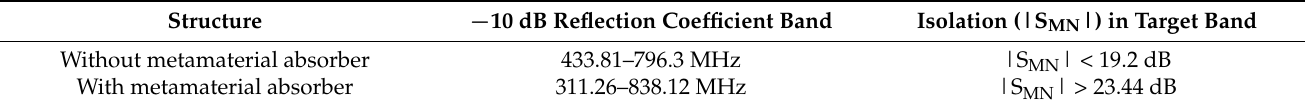
Figure 16. Proposed antenna: ( a ) geometry of proposed antenna, ( b ) simulated S-parameters of P-band, and ( c ) simulated radiation patterns at 580 MHz when Port 1 is excited. Table 5. Simulated S-parameter performances of the proposed antenna with and without metamaterial